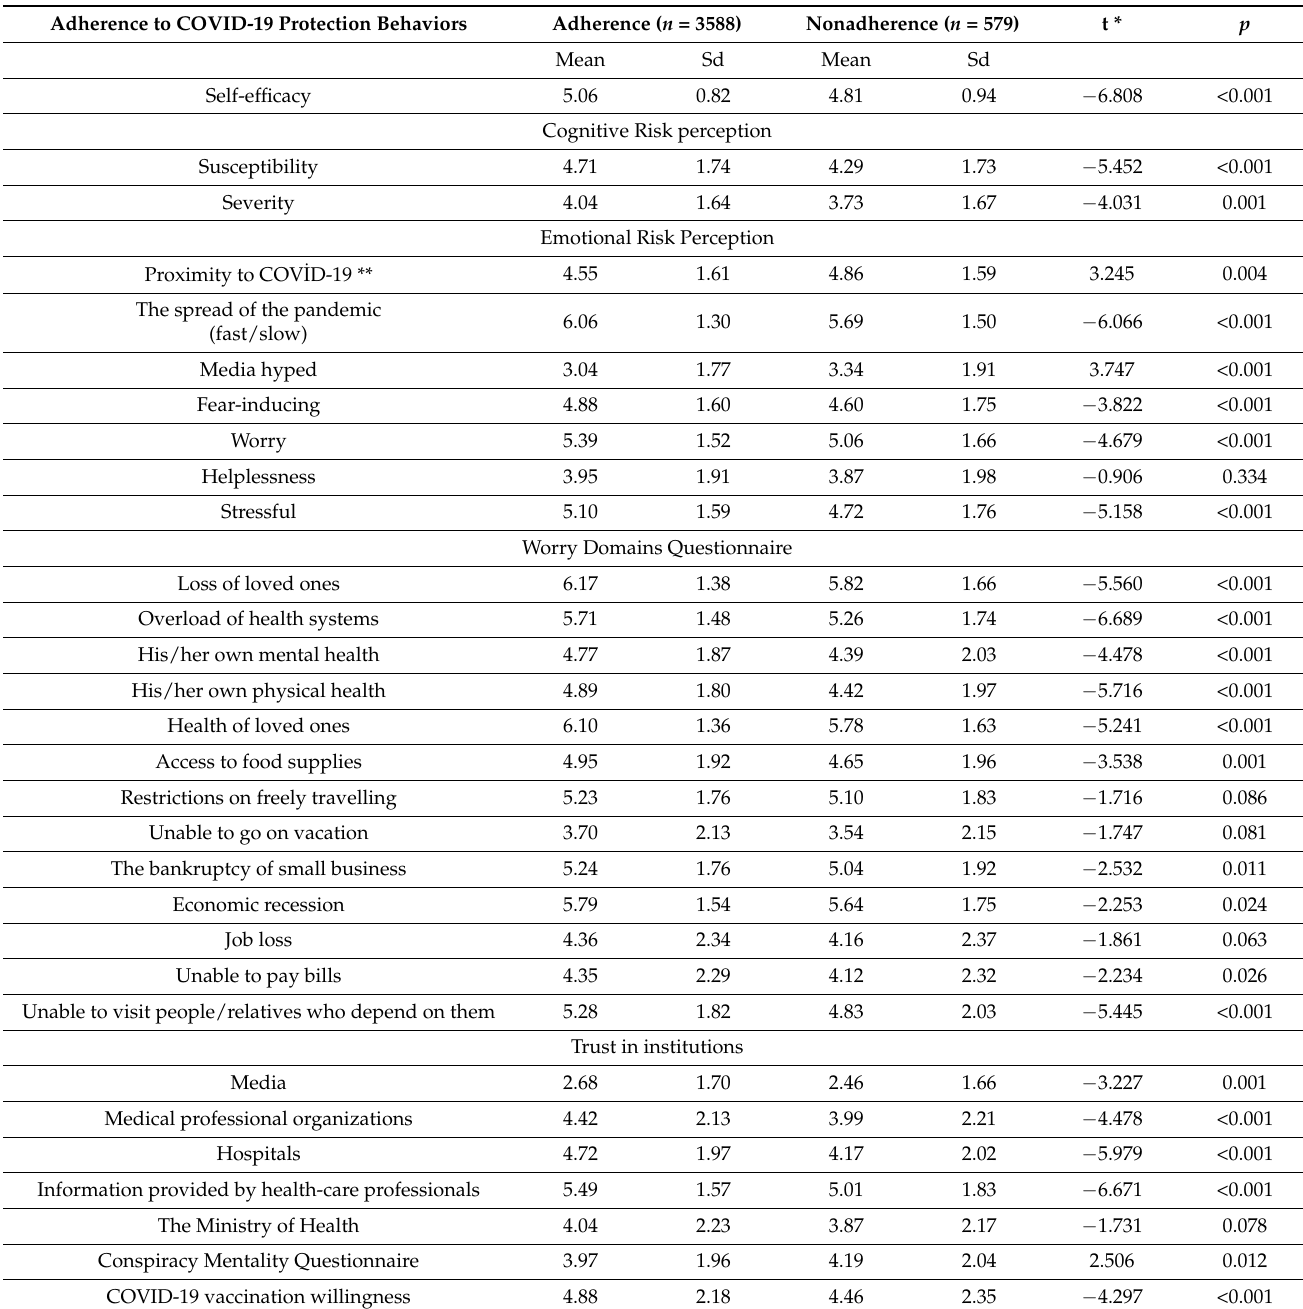
Table 2. Adherence to COVID-19 protection behaviors according to knowledge, COVID-19-related emotions, and